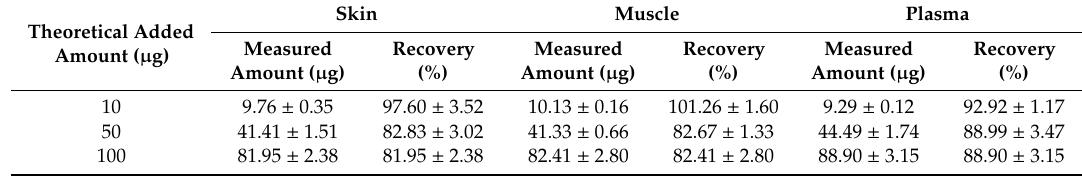
Table 1. Recovery of flurbiprofen (FBF) from porcine skin, rat muscle and rat plasma ( n = 3). Theoretical Added Amount ( µ